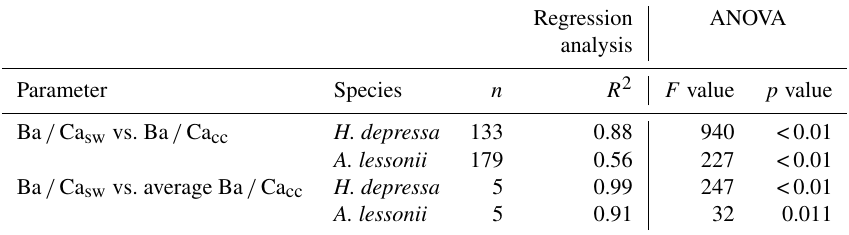
Table 3. Parameters of the regression analysis and ANOVA tests for significance of the regression. Both average Ba / Ca cc of each experi- mental condition ( n = 5) and all chamber-specific Ba / Ca cc ( n = 133 / 179) ratios were tested versus the Ba / Ca of the five treatments.